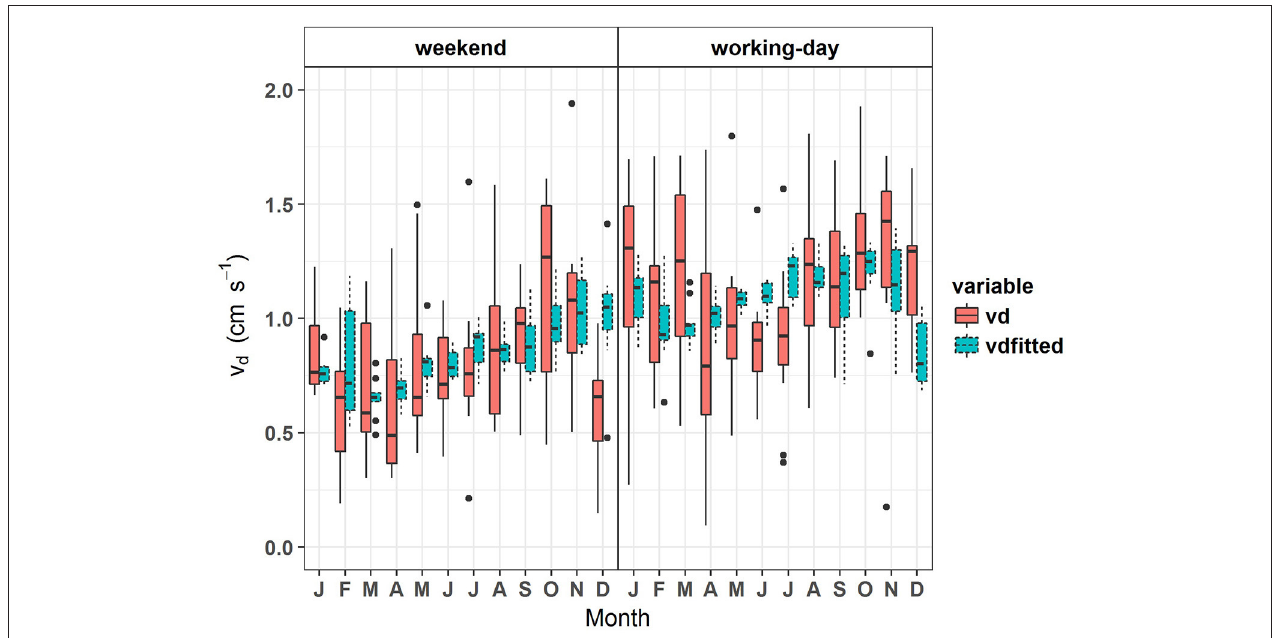
FIGURE 8 | Annual pattern of monthly measured and modeled deposition velocity ( υ d ,cm s − 1 ) for daytime weekends and working-days over the entire period April 2005 till December